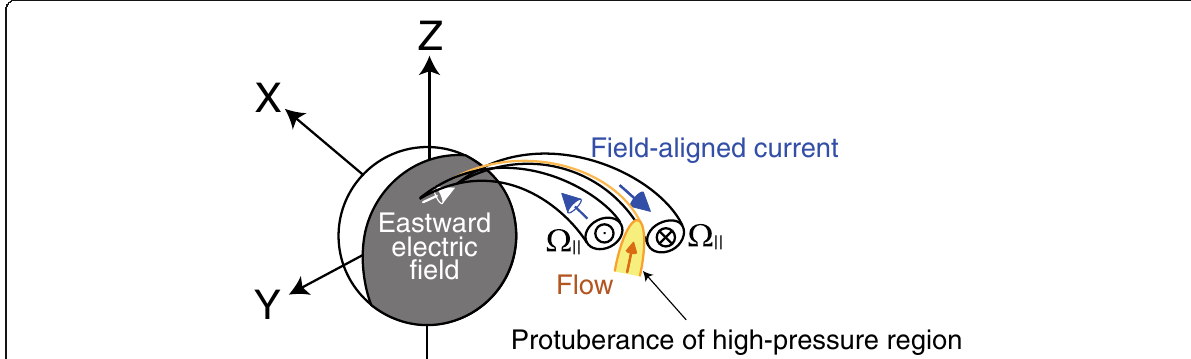
Fig. 5 A possible generation mechanism for the structured distribution of plasma pressure, which is associated with the high-latitude aurorae often observed in the growth phase. (Adapted from Ebihara and Tanaka